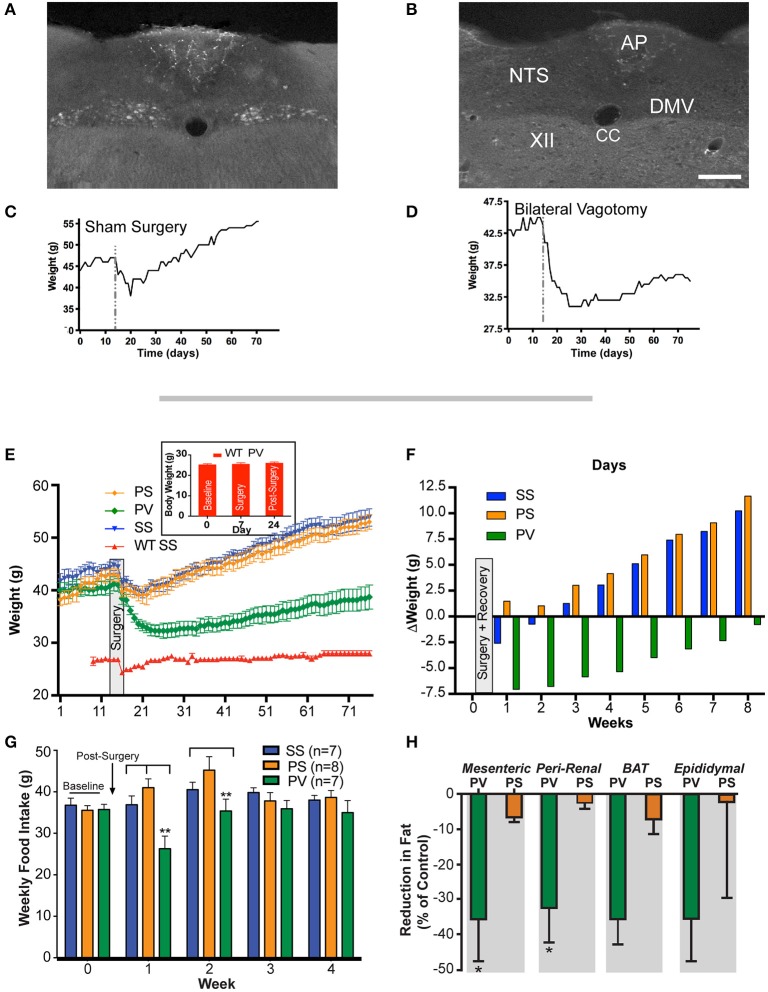
Weight gain is prevented by subdiaphragmatic vagotomy (SDV) in not yet fully obese Mc4r−/− mice (< 45 g). (A) Representative photomicrograph showing the presence of FluoroGold label in DMV neurons of a not yet fully obese Mc4r−/−mouse with intact bilateral subdiaphragmatic vagus nerves (sham SDV and sham pyloroplasty; SS). (B) Representative photomicrographs showing the absence of FluoroGold label in DMV neurons of not yet fully obese Mc4r−/−mouse with complete bilateral SDV (SDV and pyloroplasty; PV). (C) Representative associated weight curve following sham surgery. (D) Representative associated weight curve following vagotomy and pyloroplasty surgery. (E) Graph showing the effect of bilateral SDV and pyloroplasty on body weight. Male mice (Mc4r−/− or wild type; n = 6–8 per treatment group) were weighed daily after undergoing: sham SDV and sham pyloroplasty (SS, blue), sham SDV and pyloroplasty (PS, orange), SDV and pyloroplasty (PV, green), wild type sham SDV and sham pyloroplasty (WT SS, red) or wild type SDV and pyloroplasty (WT PV, insert graph). Data are expressed as the mean ± SEM of the body weight (g). (F) Graph illustrating the effect of subdiaphragmatic vagotomy and pyloroplasty on the average change in weekly body weight of Mc4r−/− mice, relative to baseline (n = 6–8 per treatment group). (G) Graph showing cumulative weekly food intake in all groups fed on a normal diet. Statistical significance in weekly food intake was obtained by comparing treatment group PV with control groups (PS and SS). (H) Bar graphs showing the percent reduction in adipose tissue in PV and PS Mc4r−/− mice (n = 6–8 per treatment group) fed a normal diet (values are expressed as mean % change (reduction) in relation to the wet weight of adipose tissue in the SS controls). *p < 0.05 and **p < 0.01 criterion for statistical significance using a one-way or two-way ANOVA and with post-hoc comparison tests (Bonferoni and Tukey). XII, hypoglossal nucleus; AP, area postrema; CC, central canal; DMV, dorsal motor nucleus of the vagus; NTS, nucleus tractus solitarius. Scale bar = 100 μm (A,B).